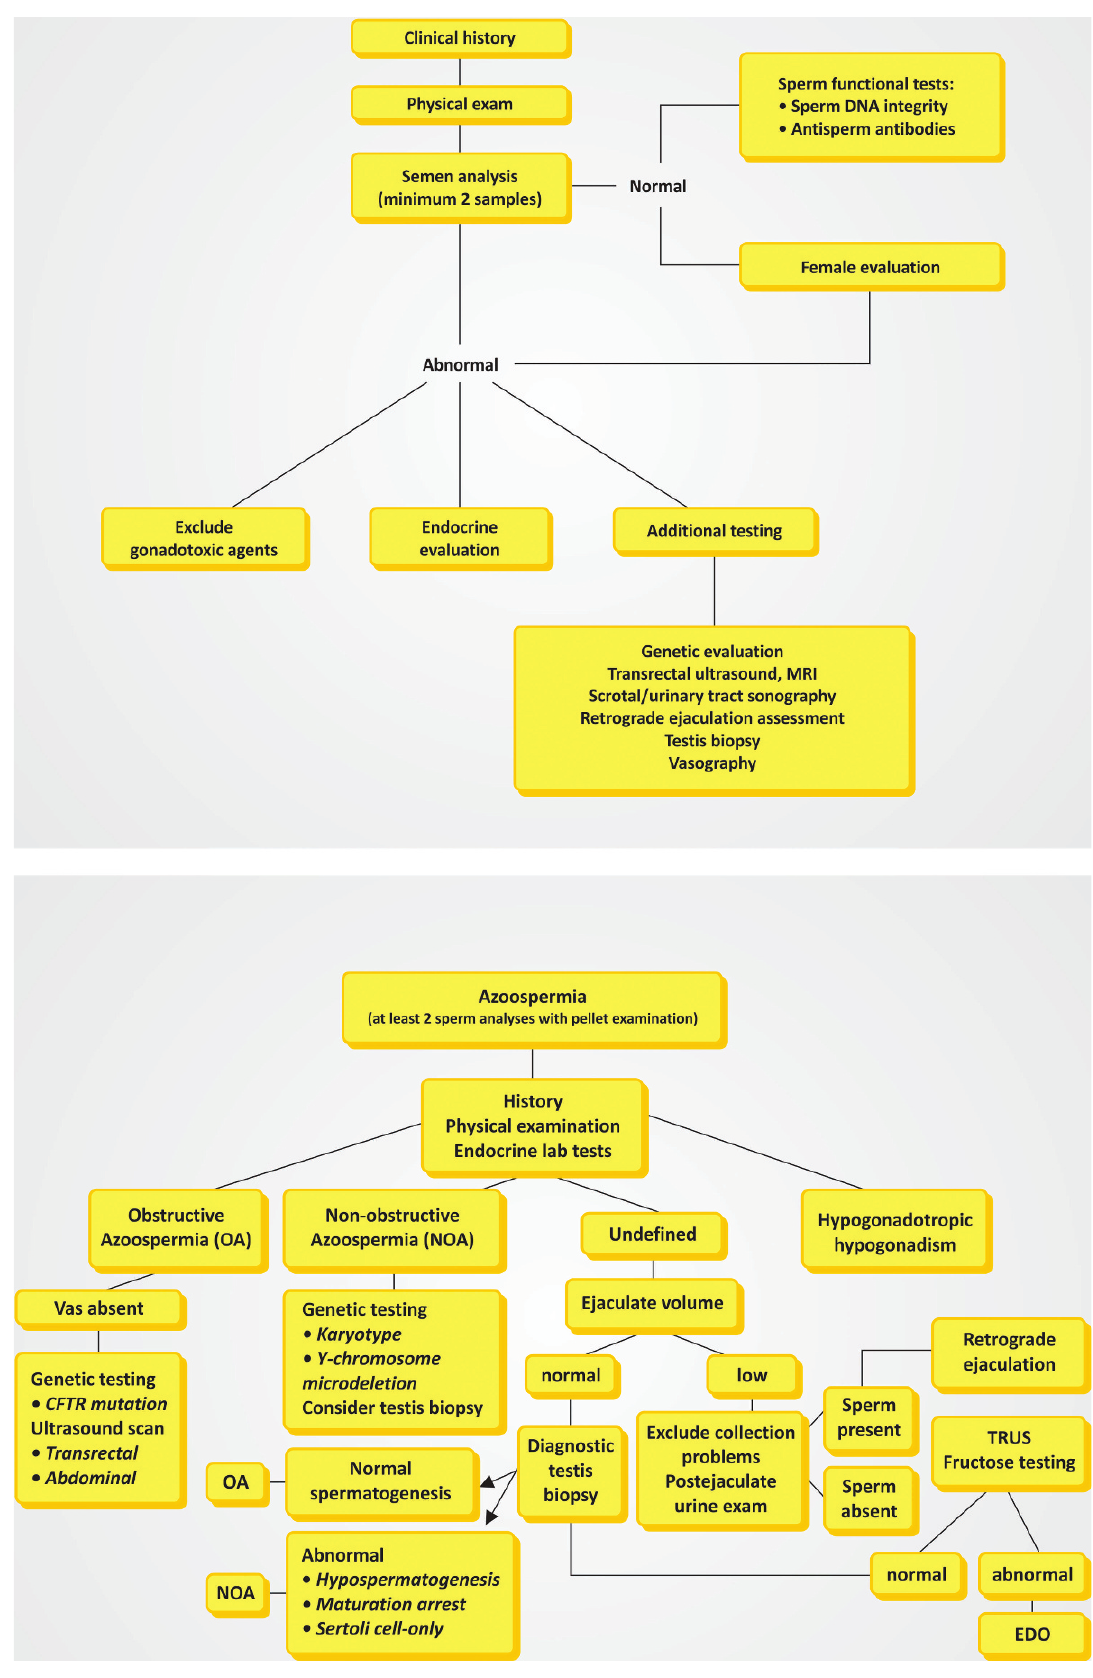
Figure 4 - Algorithms for the workup of the infertile male. Algorithm to be considered on initial assessment (top). Algorithm for the management of the patient presenting with azoospermia (bottom).